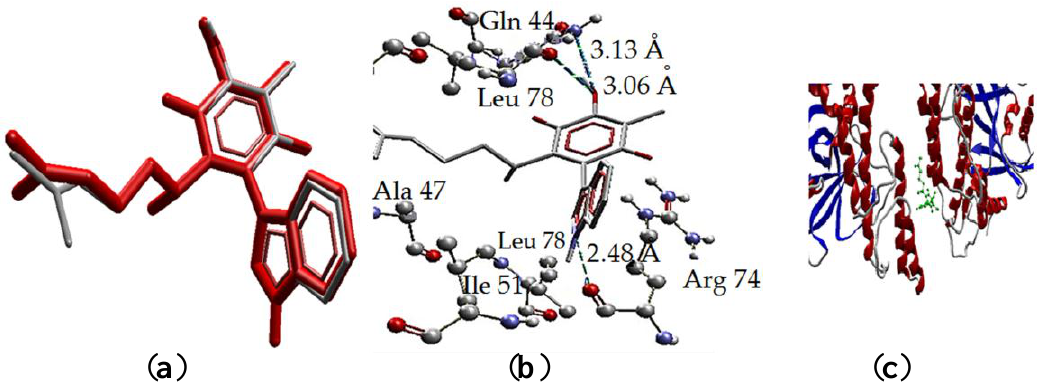
Figure 9 . Interaction of 2 with PARP−1, PDB code (1UKO). ( a ) 2 and the pose, overlapping of the Figure 9. Interaction of 2 with PARP-1, PDB code (1UKO). ( a ) 2 and the pose, overlapping of the ligand ligand (red) and the pose (grey). ( b ) Interaction of 2 and PARP−1 complex, three H bonds with protein (red) and the pose (grey). ( b ) Interaction of 2 and PARP-1 complex, three H bonds with protein residues. residues. ( c ) Secondary structure, ligand (green) in the middle of the two isomers protein. ( c ) Secondary structure, ligand (green) in the middle of the two isomers